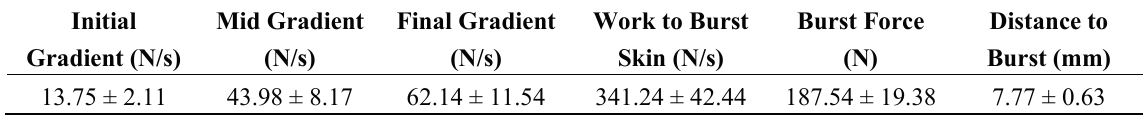
Table 1. Burst force required to rupture porcine skin ( n =